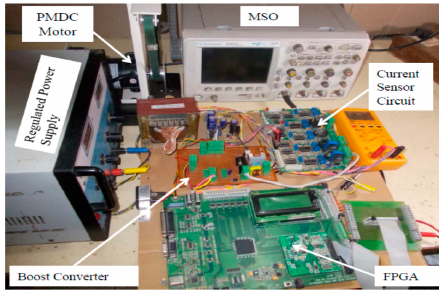
Figure 4. Frequency domain analysis of a fourth-order system. ( a ) Gain Margin ; ( b ) Phase Margin .